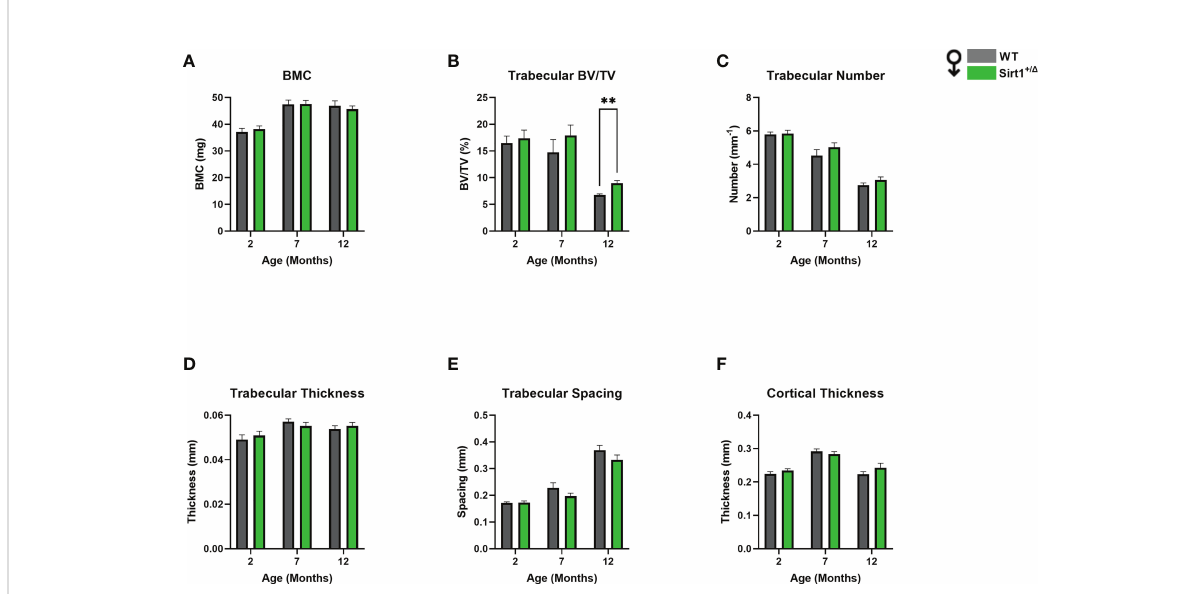
FIGURE 3 The effects of Sirt1 haploinsuf fi ciency on femoral cortical and trabecular bone parameters in Sirt1 +/ D and WT male mice. µCT analysis of femoral mid-shaft and distal metaphysis in 2, 7,12-month-old Sirt1 +/ D and WT male mice. (A) . Bone mineral content (BMC) (B) . Bone volume fraction (BV/TV%) (C) . Trabecular number (D) . Trabecular thickness (E) . Trabecular spacing (F) . Cortical thickness in mid shaft. Results are Mean ± SEM analyzed by unpaired Student ’ s t test; ** P < 0.01 versus WT male mice. (n = 7-11 mice/group).